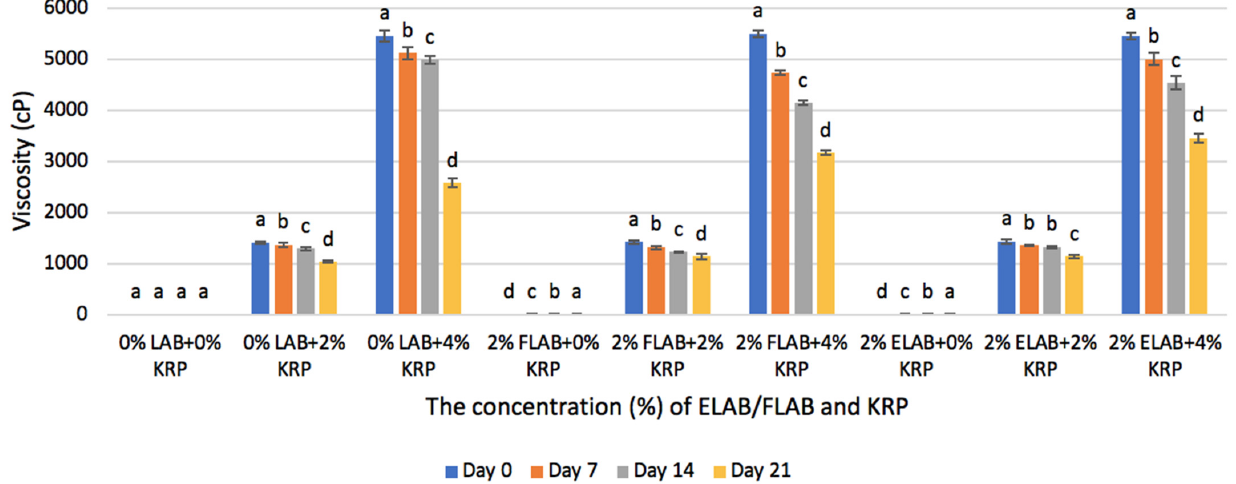
Figure 2. The impact of various concentration of KRP on the Viscosity (cP) of chocolate milk that contains 0% LAB, 2% ELAB and 2% FLAB, during the 0, 7, 14 and 21 days of storage. Standard deviation (SD) is presented in the forms of error bars. Columns with different superscript letters are significantly different (95% confidence level) within each group).